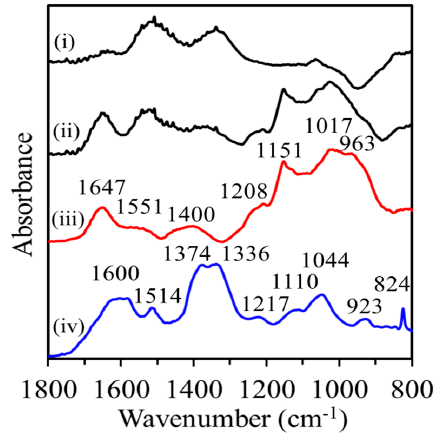
Figure 5. Results of ATR-FTIR analysis. (i) The spectrum of pristine CeNPs; (ii) The spectrum of CeNPs reacted with EPS for 1 h at pH 6.0; (iii) The difference between pristine CeNPs and CeNPs with the adsorbed EPS (red), which represents the spectrum derived from the only EPS components adsorbed onto the CeNPs; (iv) The spectrum of the unreacted EPS (blue) for comparison with (iii).